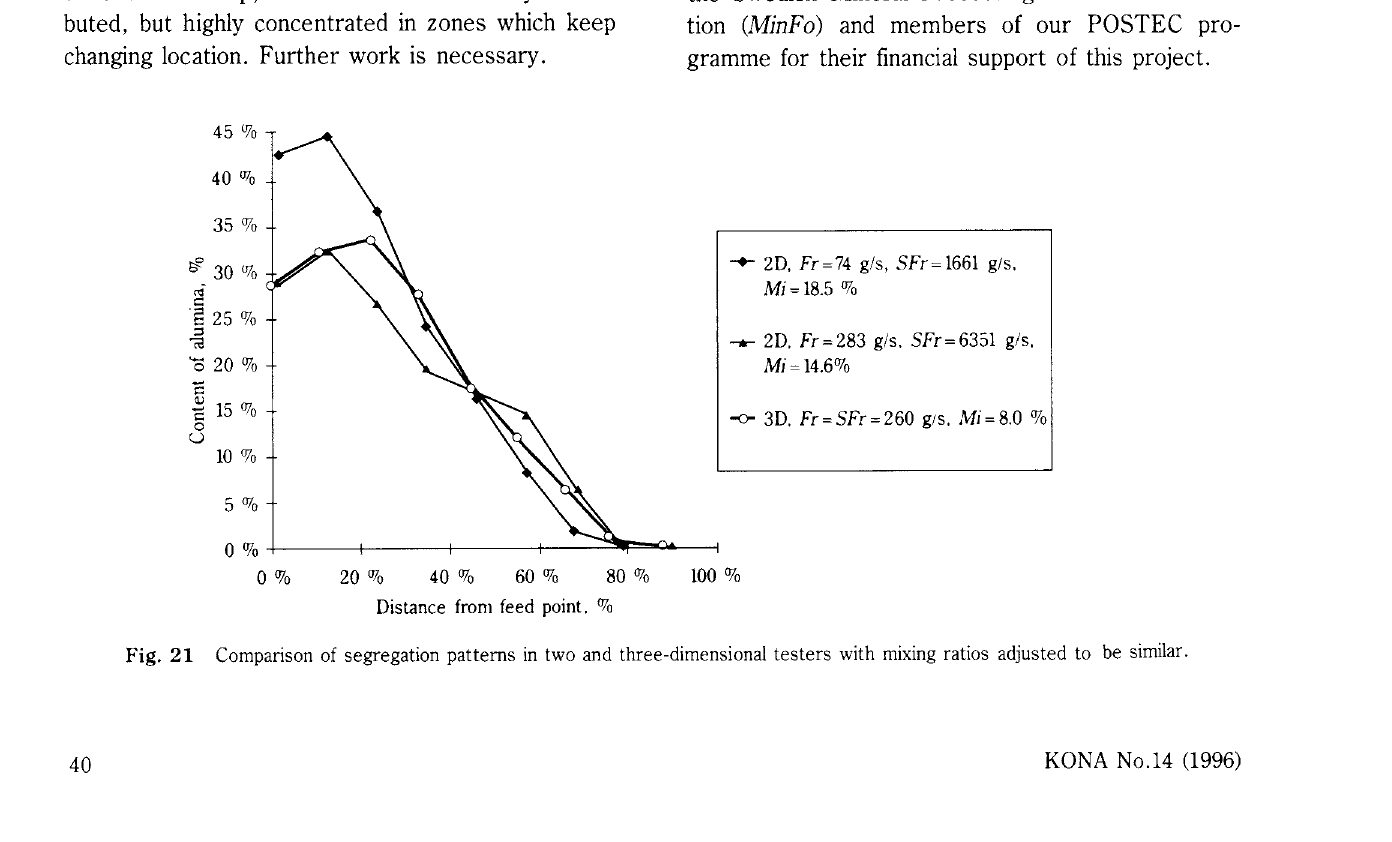
Fig. 20 Segregation patterns in the two and three-dimensional testers. Relatively low fines content.